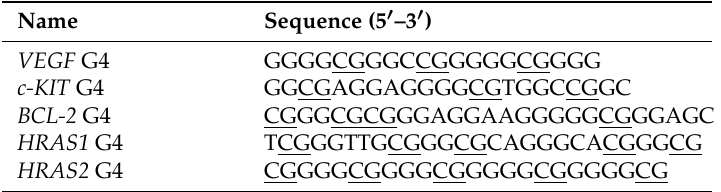
Table 1. DNA sequences used in this study.